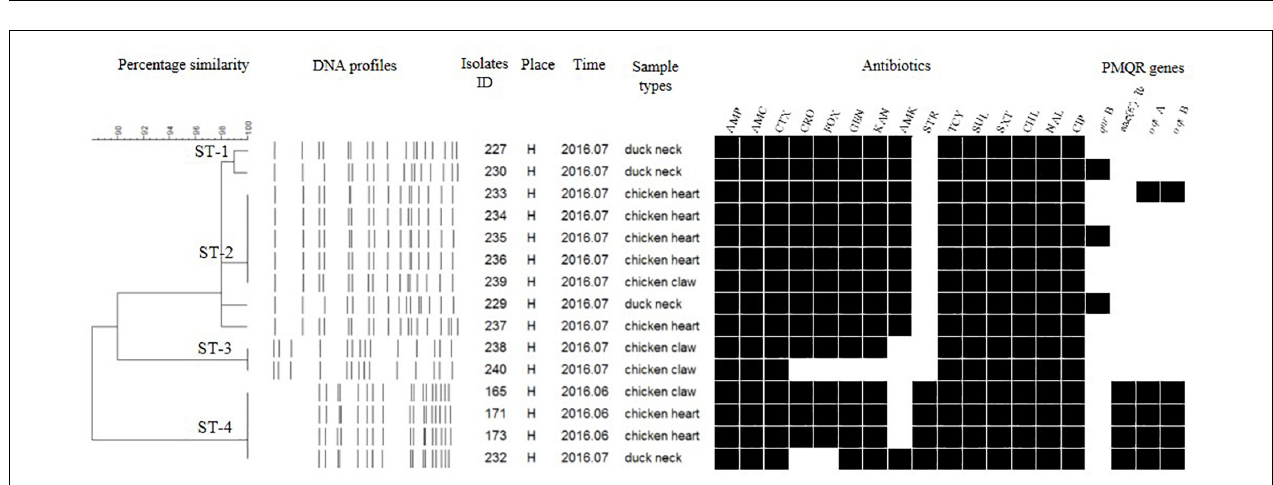
FIGURE 3 | Dendrogram of PFGE profiles for 20 S. Indiana isolates, their antibiotic resistance, and PMQR genes. Antibiotics: Ampicillin (AMP), Amoxicillin-clavulanic acid (AMC), Ceftiofur (CTX), Ceftriaxone (CRO), Cefoxitin (FOX), Gentamicin (GEN), Kanamycin (KAN), Amikacin (AMK), Streptomycin (STR), Tetracyclines (TCY), Sulfisoxazole (SUL), Trimethoprim/sulfamethoxazole (SXT), Chloramphenicol (CHL), Nalidixic acid (NAL), and Ciprofloxacin (CIP).